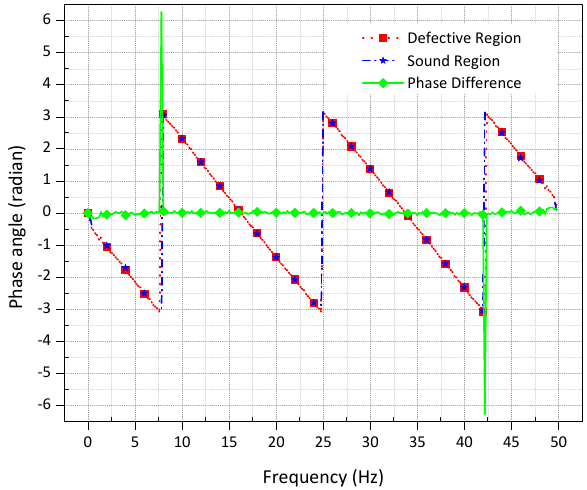
Figure 9. Phase images obtained with pulsed phase thermography for a steel plate with flat bottomed holes after pulse heating at different frequency spectra, ( a ) 0.2 Hz, ( b ) 0.4 Hz, ( c ) 8 Hz, ( d ) 25 Hz ( e ) 42.6 Hz and ( f ) 50 Hz, number of frames =250 frames, truncation window 5 s. Phase angle scales are in radian.